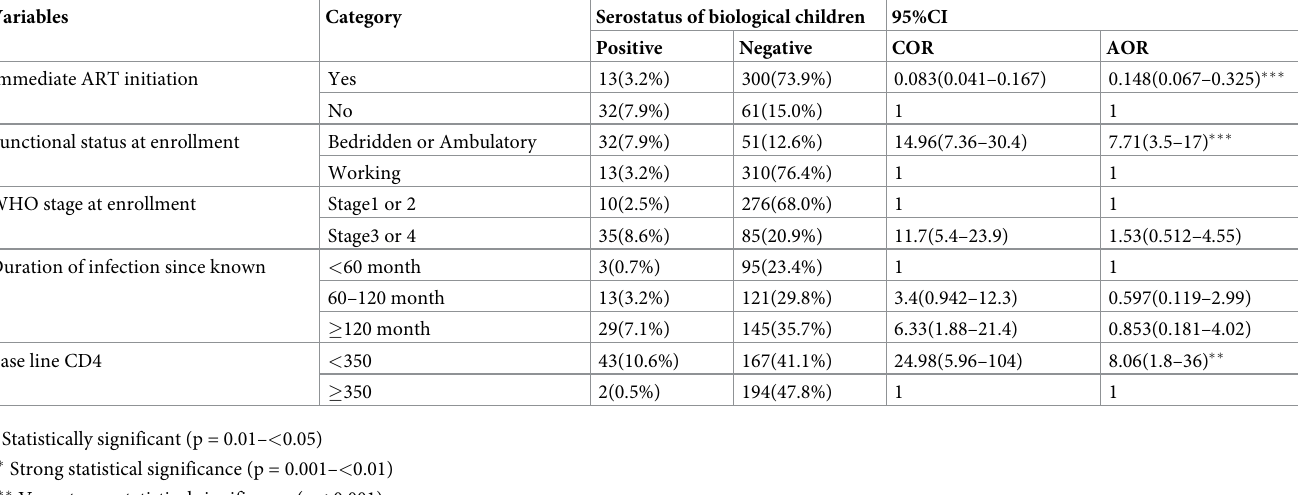
Table 7. Factors associated with seropositive status among biological children of index cases in Sodo Town, 2021 (N =